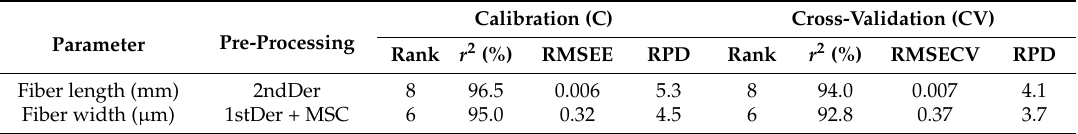
Table 4. Results of the calibration and cross-validation for all samples (60 samples) for fiber length (weighted in length) and width of Acacia melanoxylon pulps, using the best pre-processing methods of the raw spectral data.